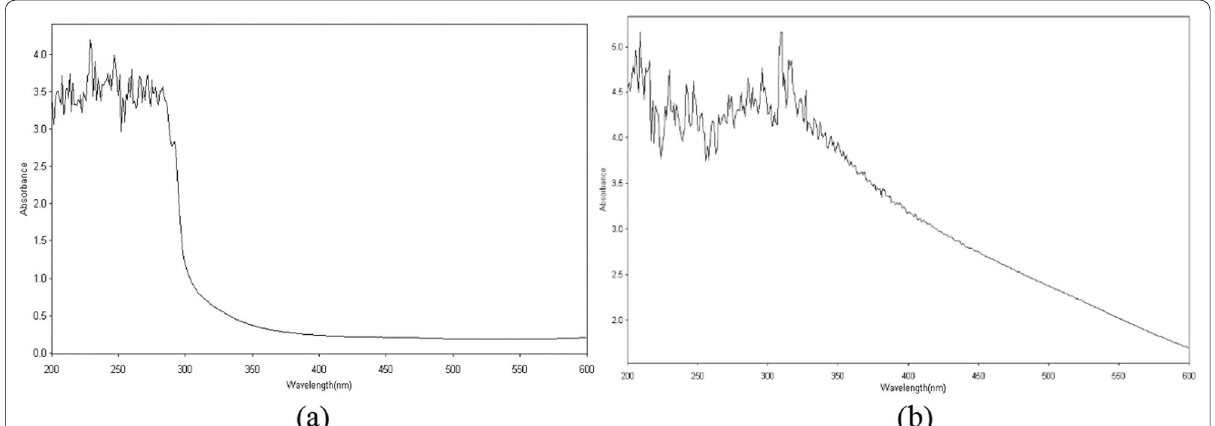
Fig. 1 UV–visible spectrum a for Grewia asiatica L . leaves extract, b biosynthesized copper nanoparticles